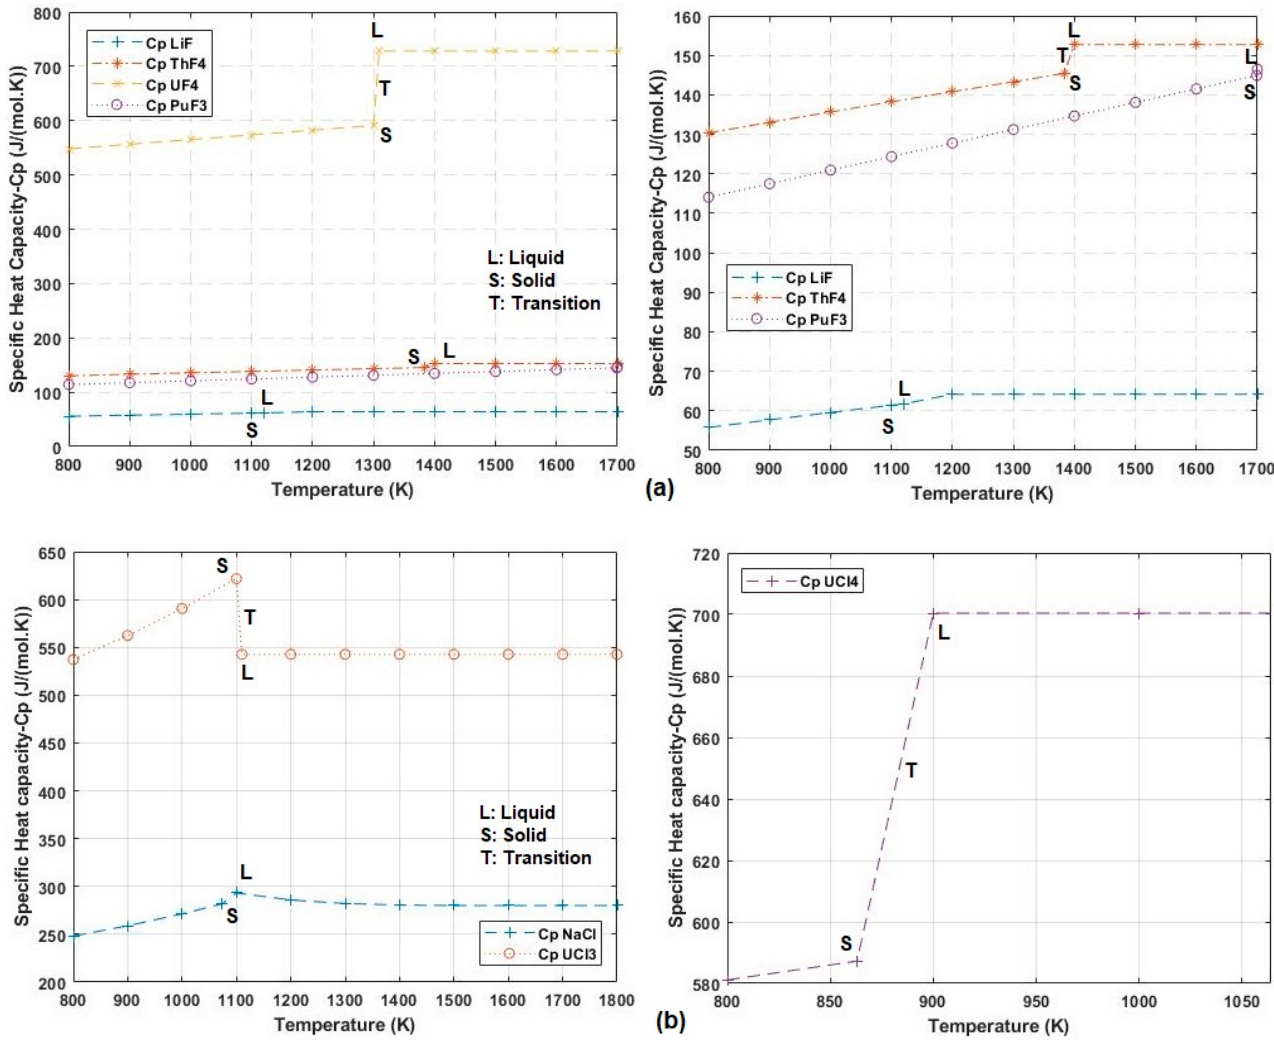
Figure 4. Specific heat capacity of ( a ) EVOL and ( b ) iMAGINE salt fuel system components [28–